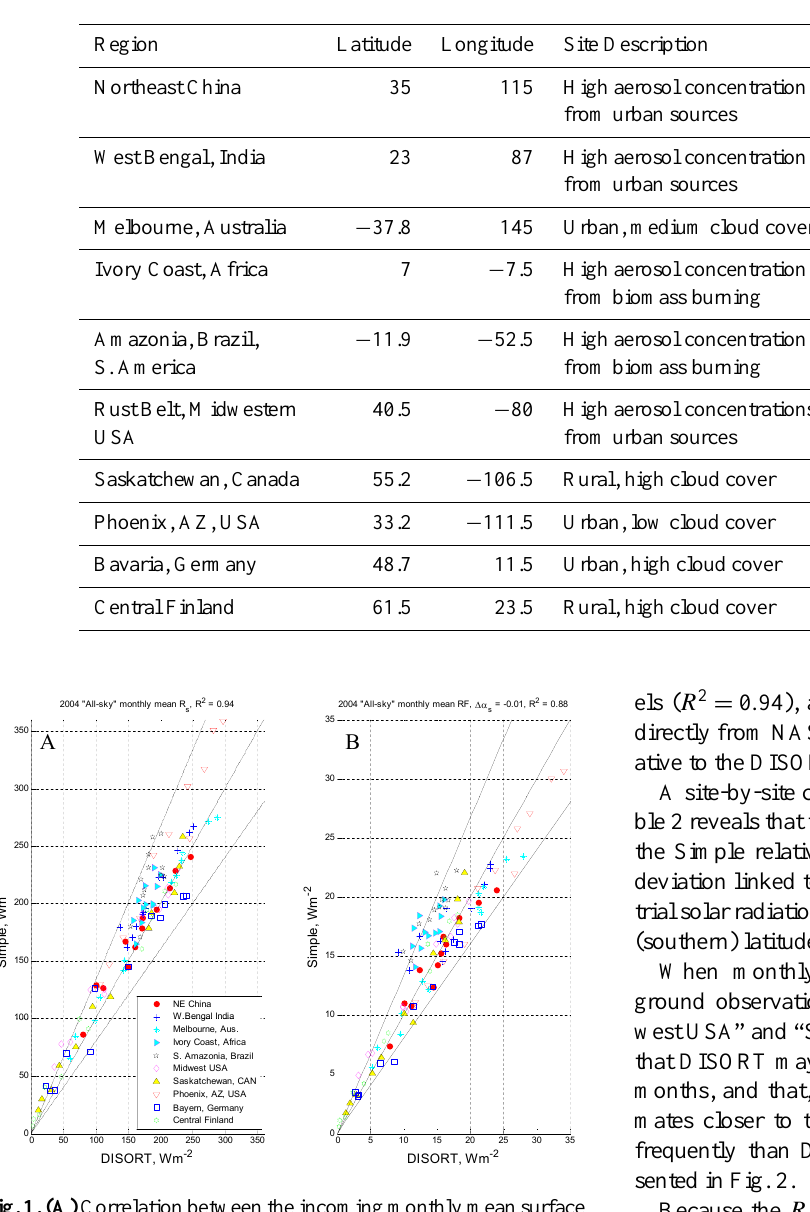
from NASA SSE for the same year and region (NASA,